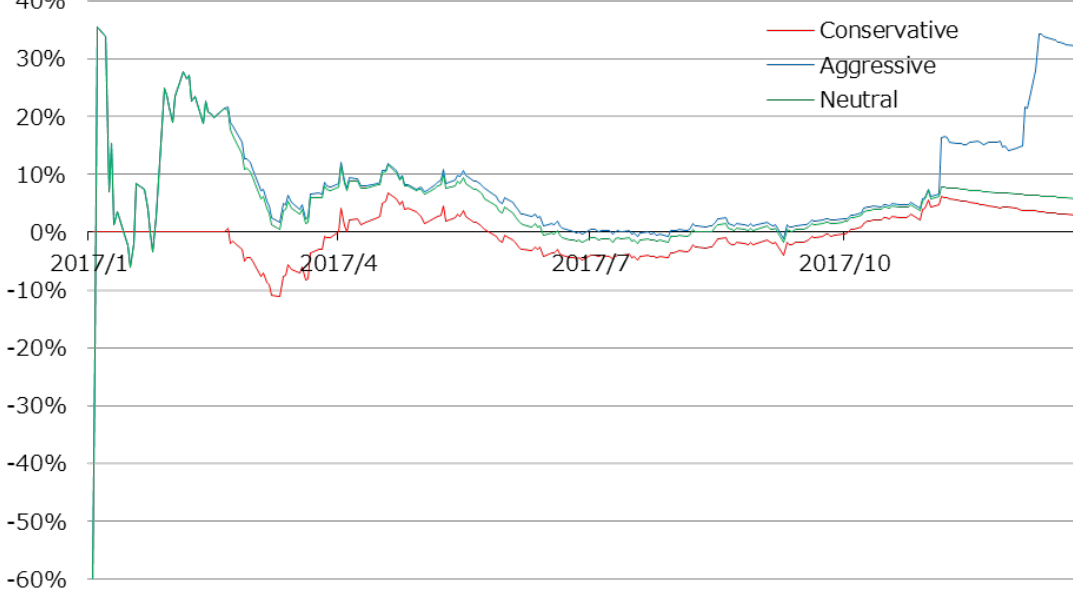
Figure 7. Figure 7. Yield.